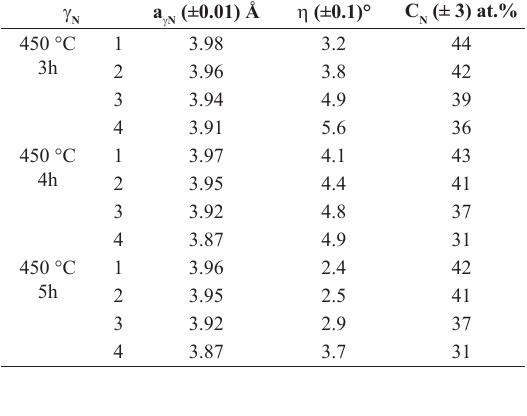
Table 4. Values for Lattice parameter ( a ), Distortion ( η ) and ) for each sublayer of the g phases used Nitrogen concentration ( C N N in DRX pattern fittings for samples nitrided at 450 °C.